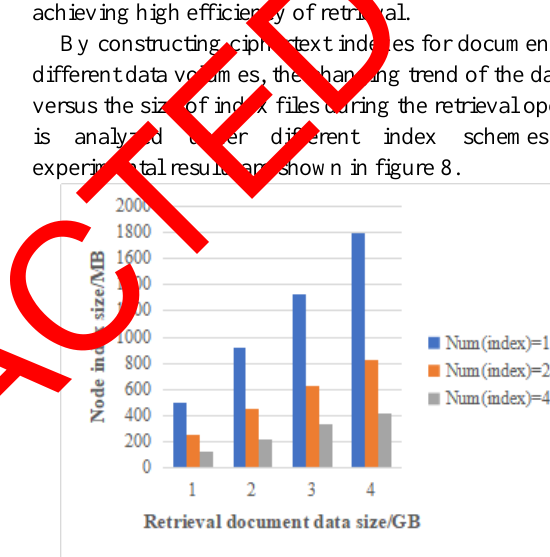
Figure 6. Comparison of retrieval efficiency between different index encryption methods